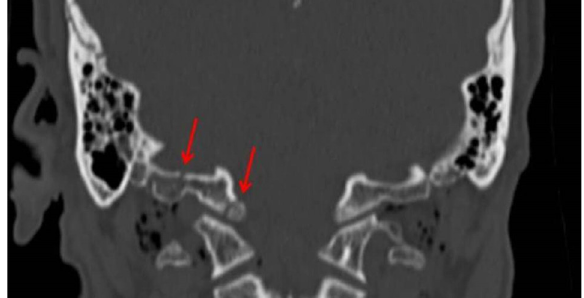
Figure 2. Non-contrast enhanced CT of the head coronal section in the bone window shows fracture of occipital condyle and posterior skull base on the right side (red arrows).